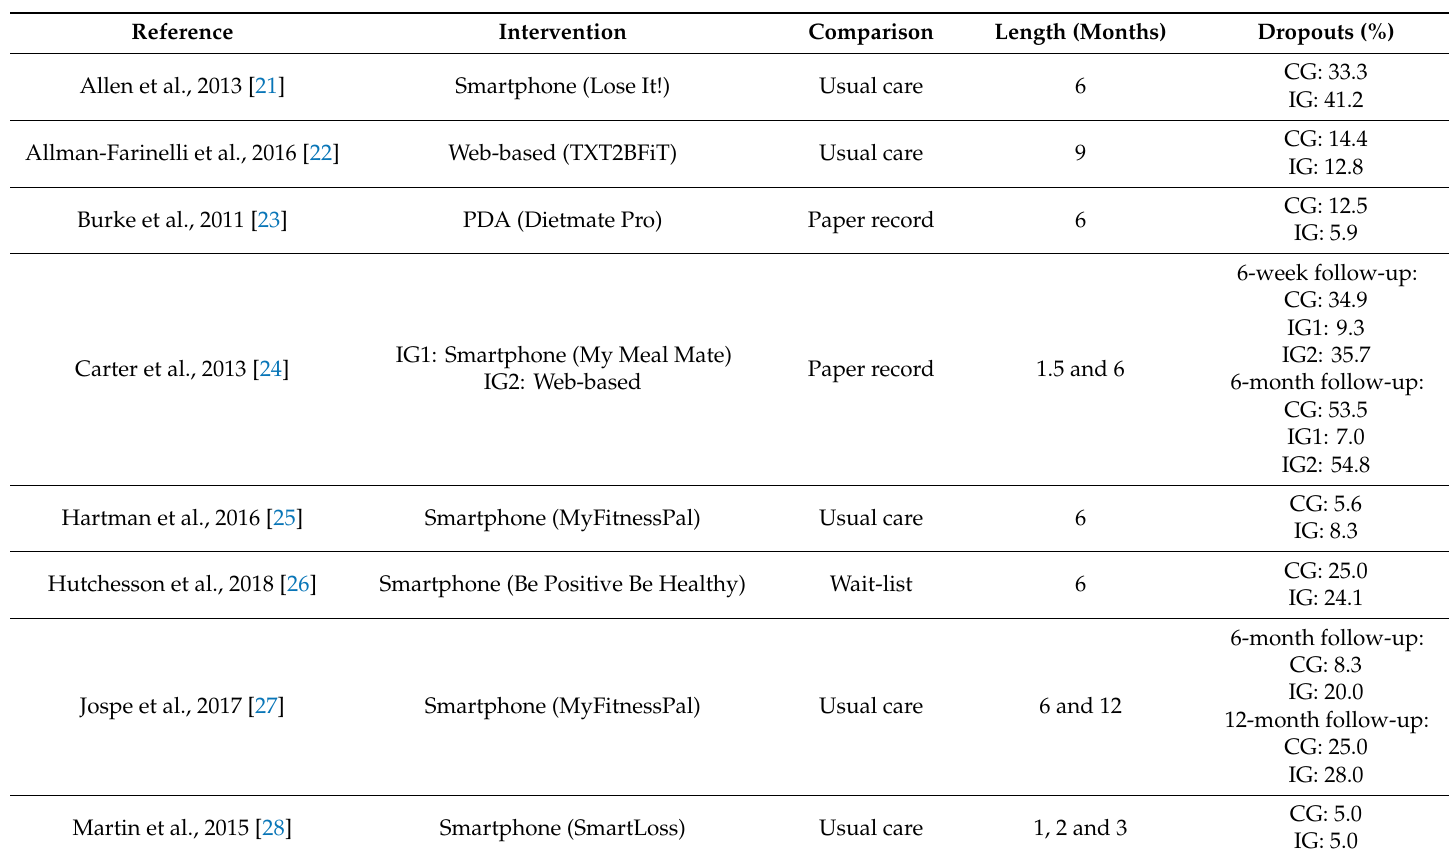
Table 2. Characteristics of type of interventions in the